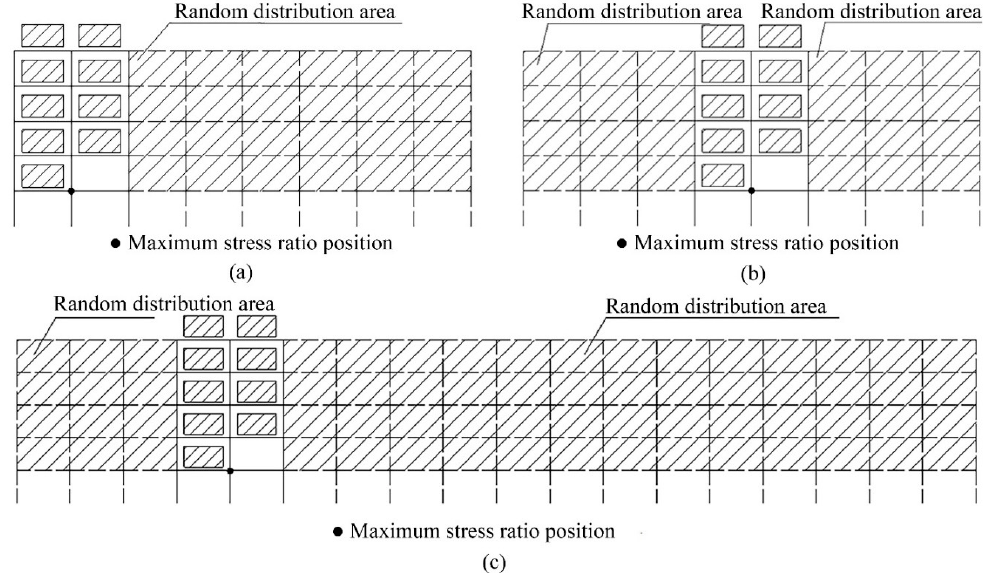
Figure 23. Comparison of three distribution modes of load. ( a ) "Right convex" mode of load distribution appears at the edge of rack. ( b ) "Right convex" mode of load distribution appears at the middle of rack. ( c ) "Right convex" mode of load distribution appears at the other positions of rack. Table 7. Relations between the distribution mode of load and the stress of the upright.